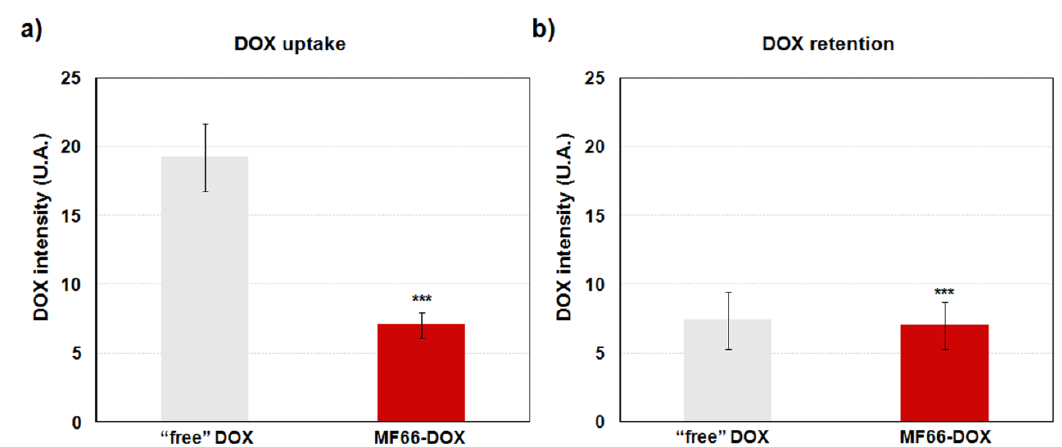
Figure 4. DOX e ffl ux by MDA-MB-231 cells incubated with the drug dissolved in medium (“free” DOX) or linked to MF66. ( a ) Intracellular DOX level measured by flow cytometry after 24 h incubation. ( b ) DOX retention at 72 h after that 24 h